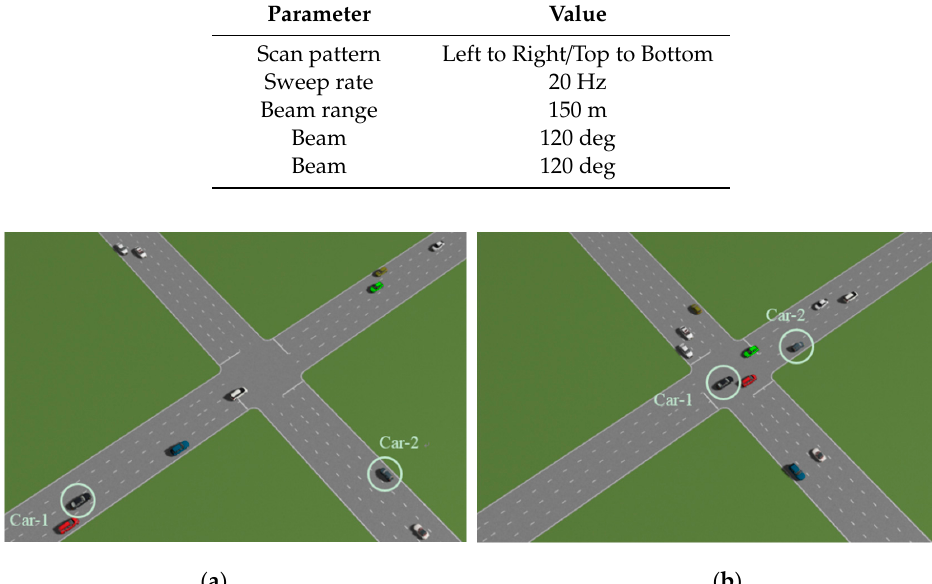
Figure 7. PreScan simulation. ( a ) Starting time; ( b ) Ending time.